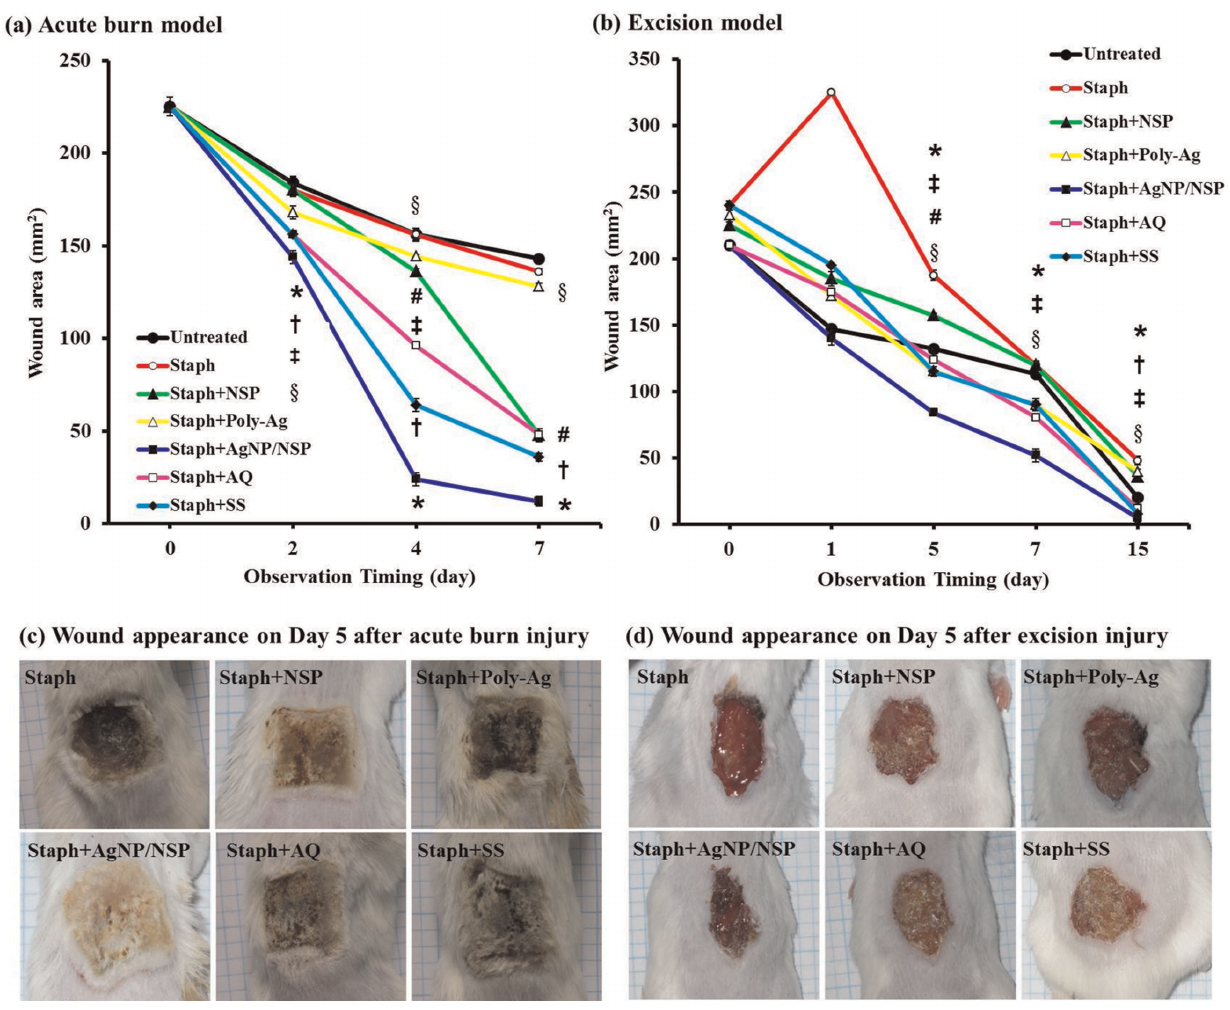
Figure 2. Wound healing rates on (a) acute burn model (b) excision wound model and the photographs of wound appearance on day 5 after (c) acute burn injury and (d) excision injury. The rate of infected wound healing was compared in animals treated with staphylococcus only (Staph), staphylococcus and NSP (Staph + NSP), staphylococcus and Poly-Ag (Staph + Poly-Ag), staphylococcus and AgNP/NSP (Staph + AgNP/NSP), staphylococcus and Aquacel H (Staph + AQ), staphylococcus and silver sulfadiazine (Staph + SS), and control (untreated). The